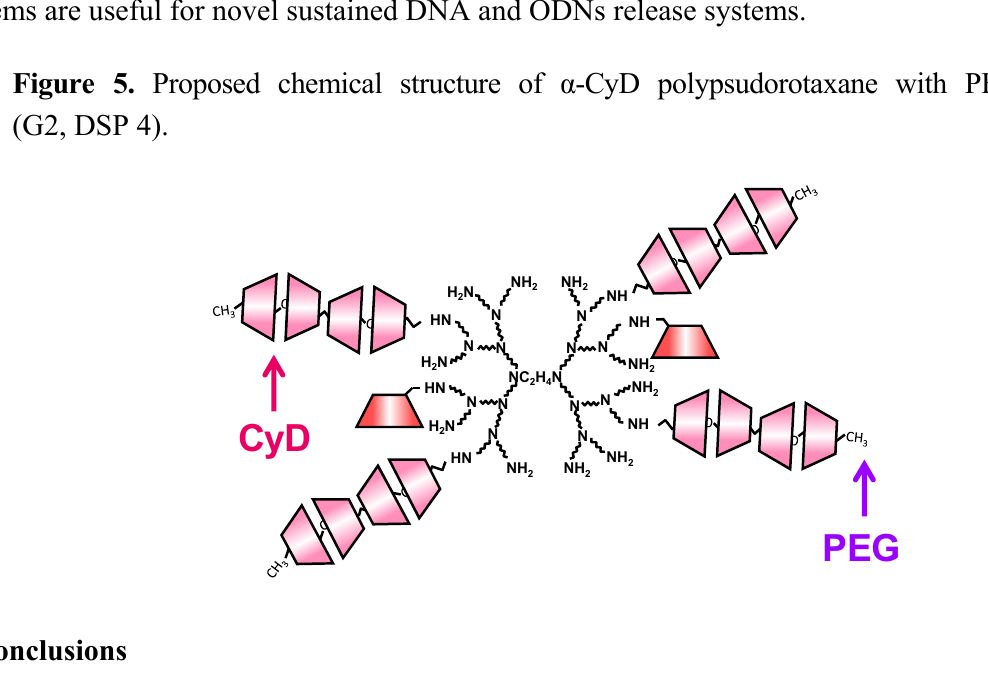
Figure 5. Proposed chemical structure of α -CyD polypsudorotaxane with PEG- α -CDE (G2, DSP 4).